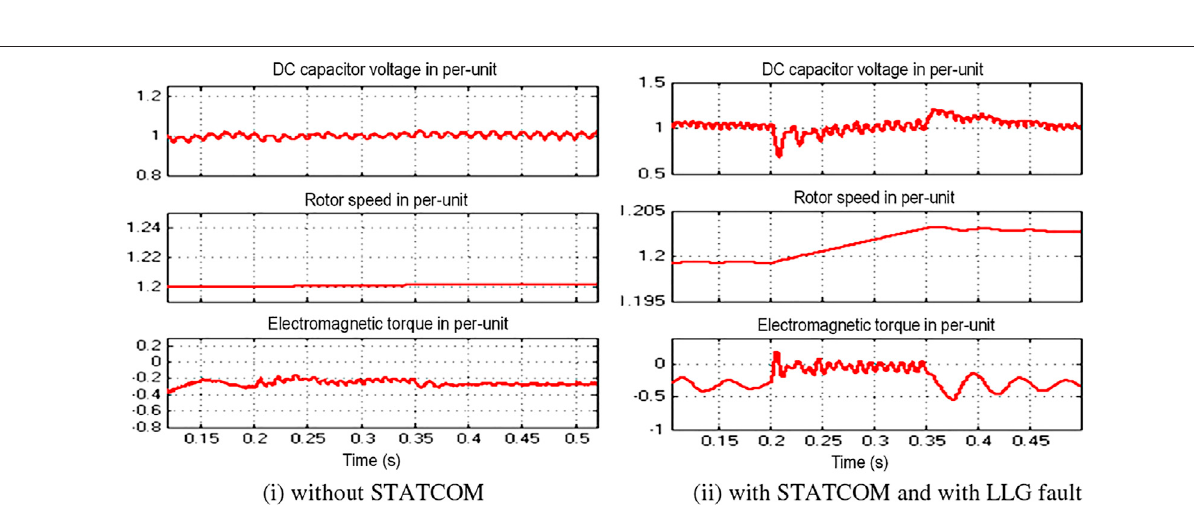
Frontiers in Energy Research |